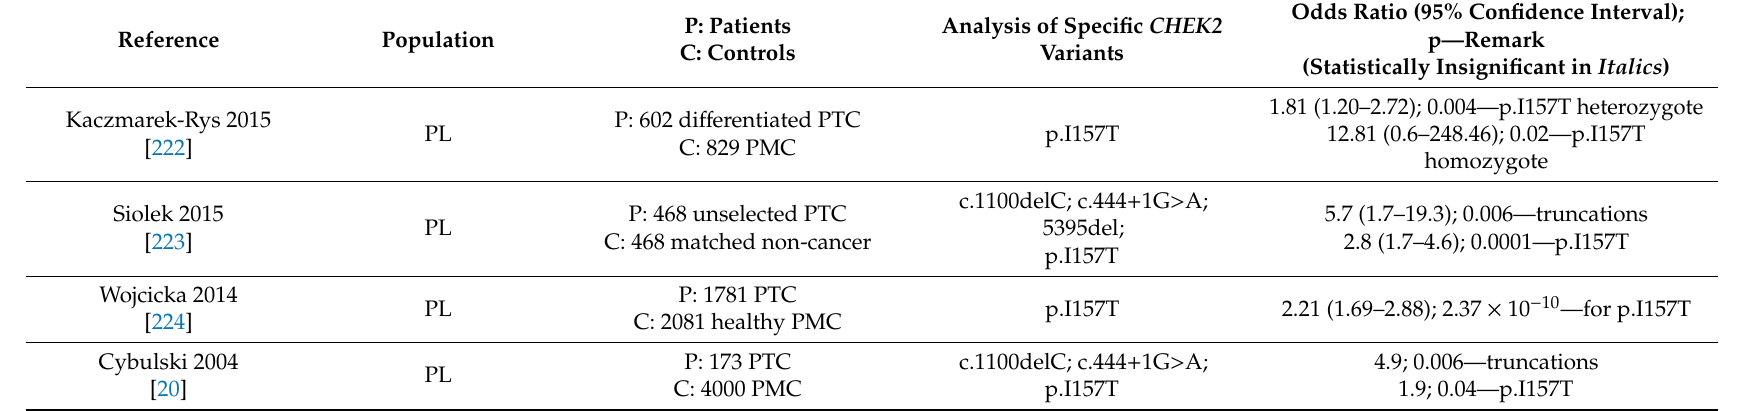
Table 4. Analyses of the CHEK2 variants in Polish (PL) patients with papillary thyroid cancer